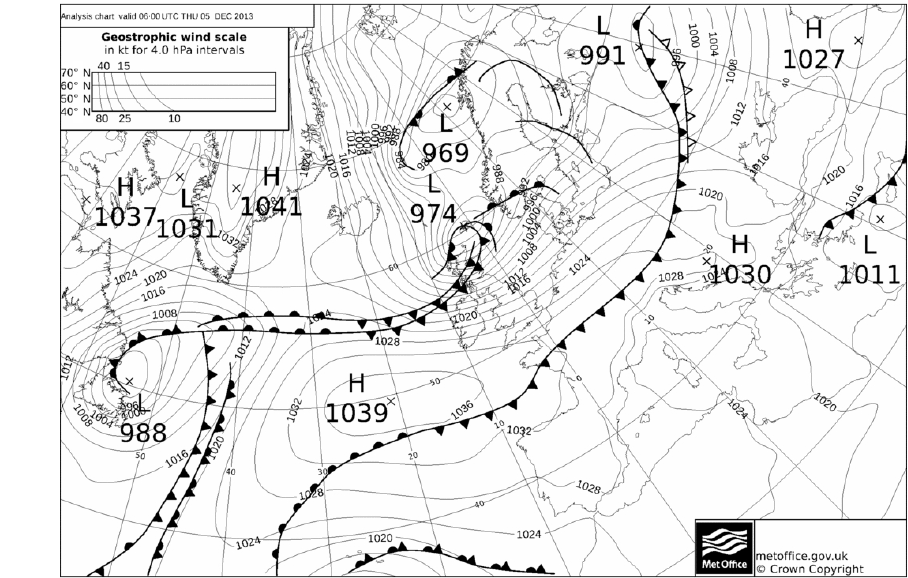
Figure 5. Synoptic chart of storm “Xaver” on 5 December 2013 at 06:00UTC. © Crown Copyright (Met Office, UK).